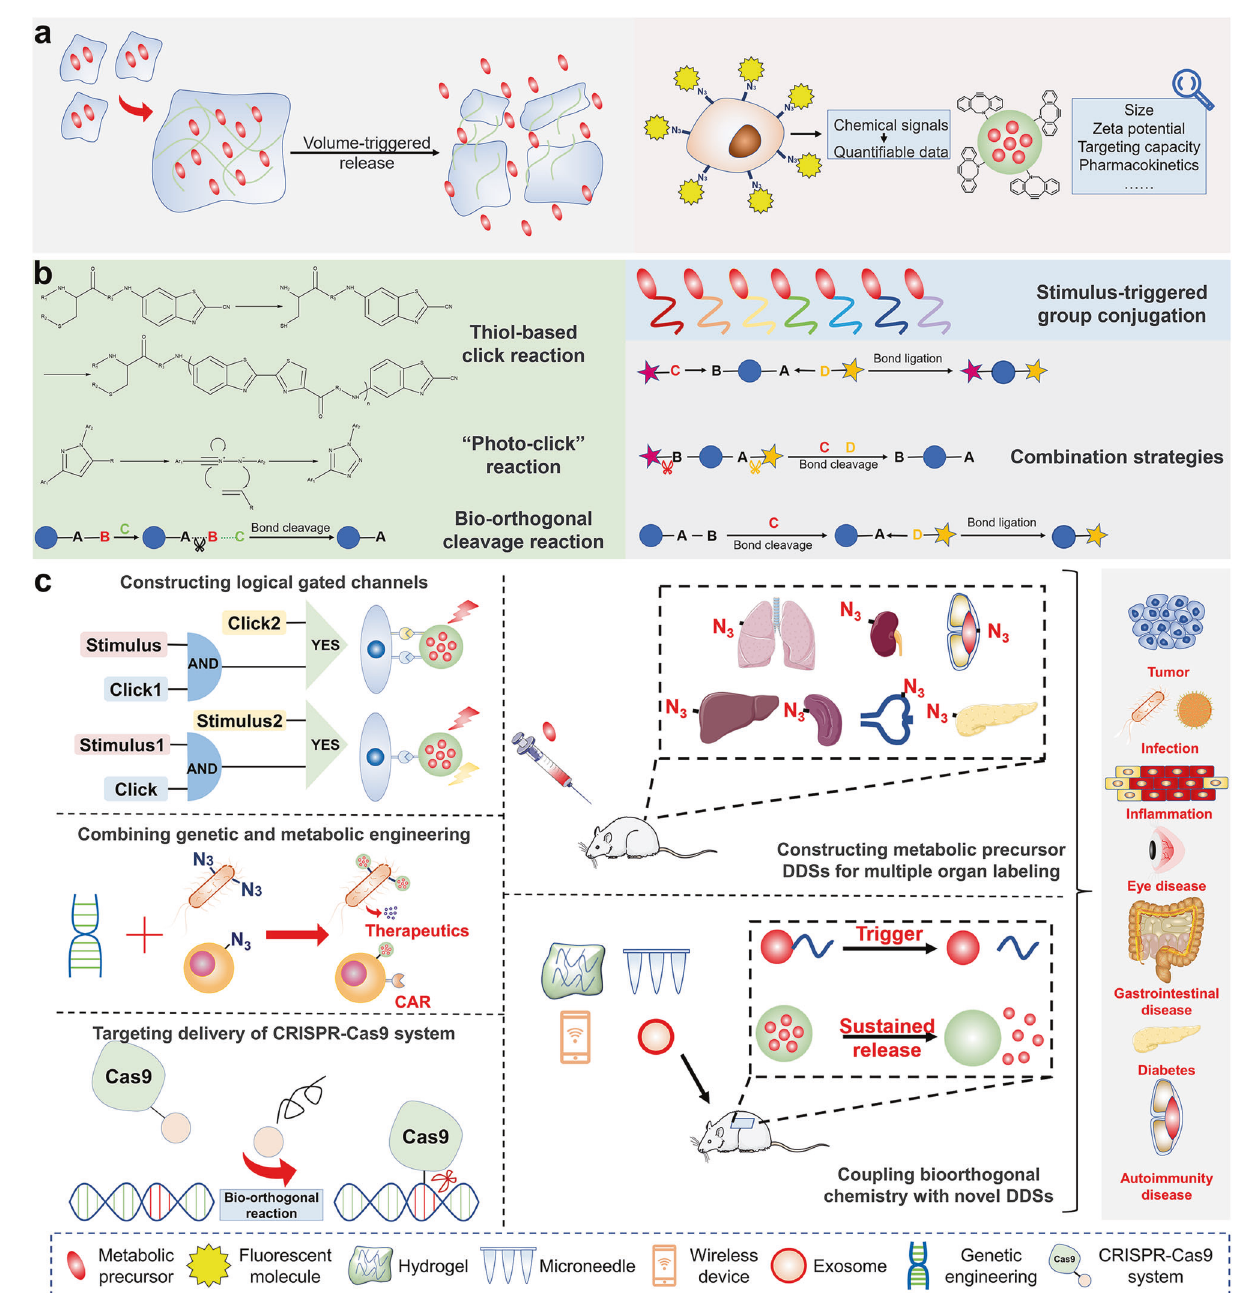
Fig. 7 Outlook of bioorthogonal chemistry in developing DSSs. a Precise regulation of bioorthogonal metabolic labeling. 1. Sustained release of metabolic precursors by constructing a volume-triggered release system, resulting in a stable bioorthogonal label in vivo. 2. Developing fl uorescent markers for accurate quanti fi cation of cell surface bioorthogonal groups while comprehensively assessing the physicochemical and pharmacokinetic properties of paired group-modi fi ed nanocarriers. b Enriching the bioorthogonal toolkit. Many intelligent metabolic precursors will be created by modifying stimuli-triggered groups. Developing various novel bioorthogonal reactions or combining multiple bioorthogonal reactions will improve the selectivity and functionality of DDSs. c Cross-integration with emerging technologies. 1. Constructing logical gated channels for precise targeting and release of drugs. 2. Combining genetic and metabolic engineering to develop multi-functional cell-based DDSs. 3. Targeting delivery of CRISPR-Cas9 system using bioorthogonal chemistry. 4. Constructing metabolic precursor DDSs that can selectively label different organs or tissues for the treatment of various diseases. 5. Coupling bioorthogonal chemistry with novel DDSs such as hydrogels, microneedles, wireless devices, and exosomes to achieve stimulus-triggered and sustained drug immunomodulatory responses when immobilized in collagen hydrogels by bioorthogonal chemistry at one-tenth the dose required for non-immobilized EV. This technique is expected to be applied to CAR-T and others to improve their intratumoral retention time and improve the ef fi cacy of cell therapy.